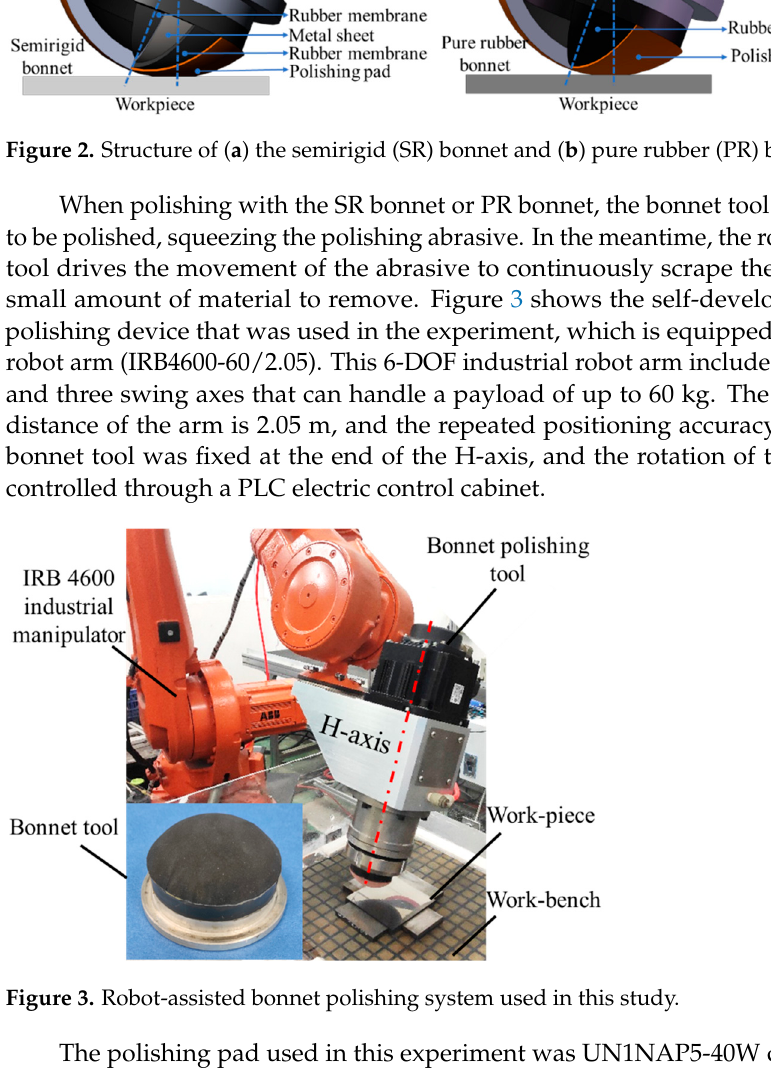
Figure 3. Robot-assisted bonnet polishing system used in this study.